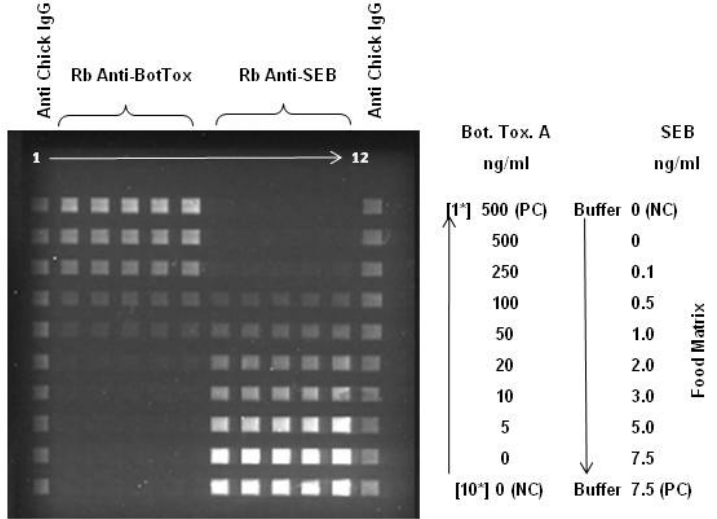
Figure 2 . Simultaneous detection of botulinum toxoid A and SEB spiked into apple juice. The slide was patterned with anti-botulinum toxin (left half) and anti-SEB antibodies (right half). Apple juice samples spiked with botulinum toxoid A (concentration decreasing) and SEB (concentrations increasing) were flowed over the patterned surface. Subsequent incubation with a mixture of labeled "tracer" antibodies directed against both toxins was followed by